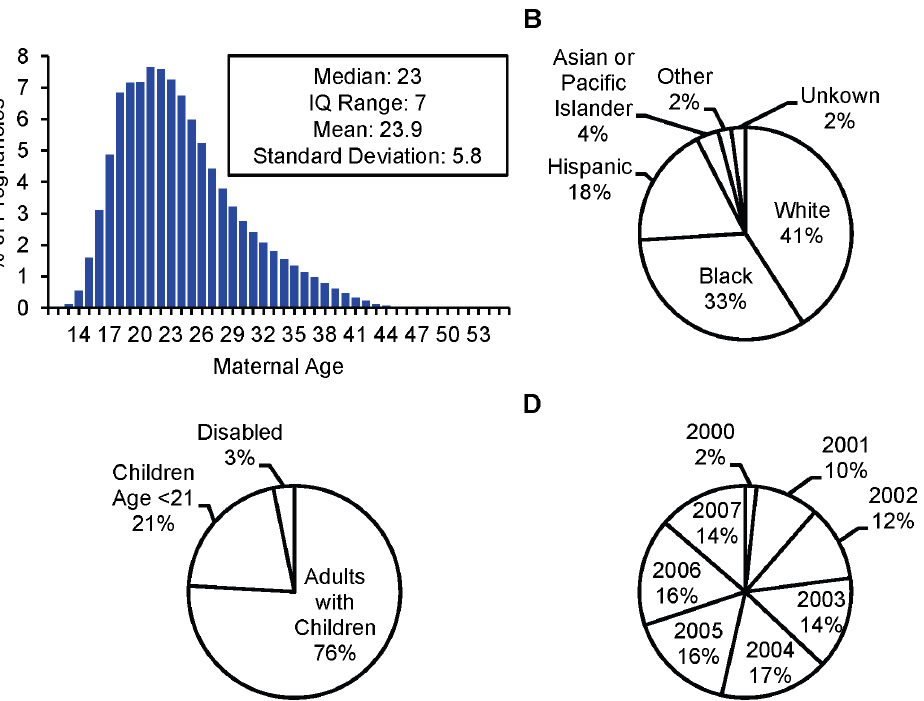
Figure 6. The distribution of maternal characteristics in the base cohort; Medicaid Analytic eXtract, 2000–2007. A) Age, B) Race, C) Medicaid Eligibility Group, and D) Delivery Year.